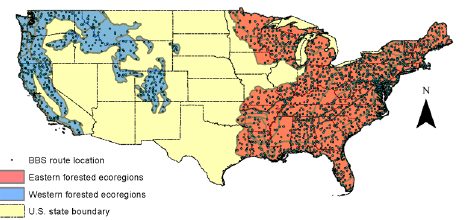
Figure 2. Distribution of BBS routes through the primarily forested ecoregions in the U.S. The richness models for the woodland guild were built using data from both eastern and western forested ecoregions. The forest edge and interior forest bird richness was modeled in the eastern forested ecoregions only.